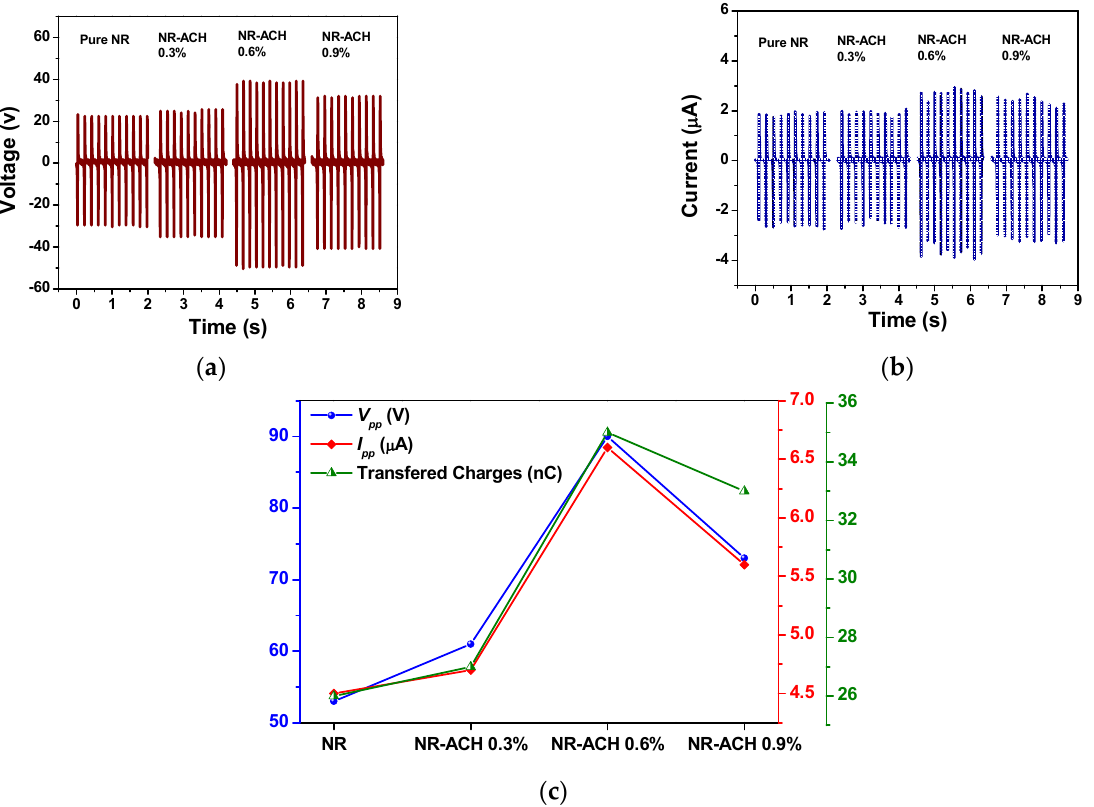
Figure 3. ( a ) Output voltage, ( b ) output current, and ( c ) transferred charges of NR and NR-ACH 0.3, 0.6 and 0.9% TENGs.